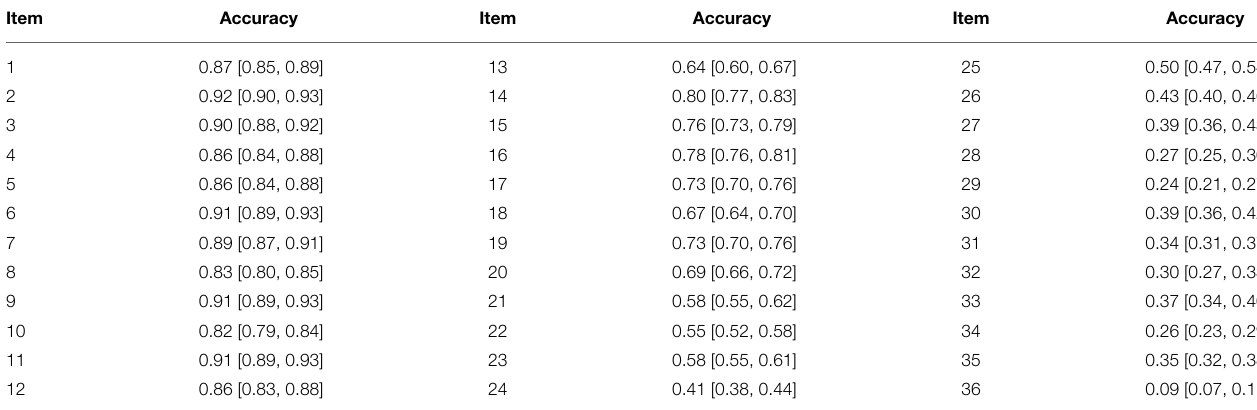
TABLE 1 | Accuracy on the consecutive Raven-test items [with the 95% confidence intervals].